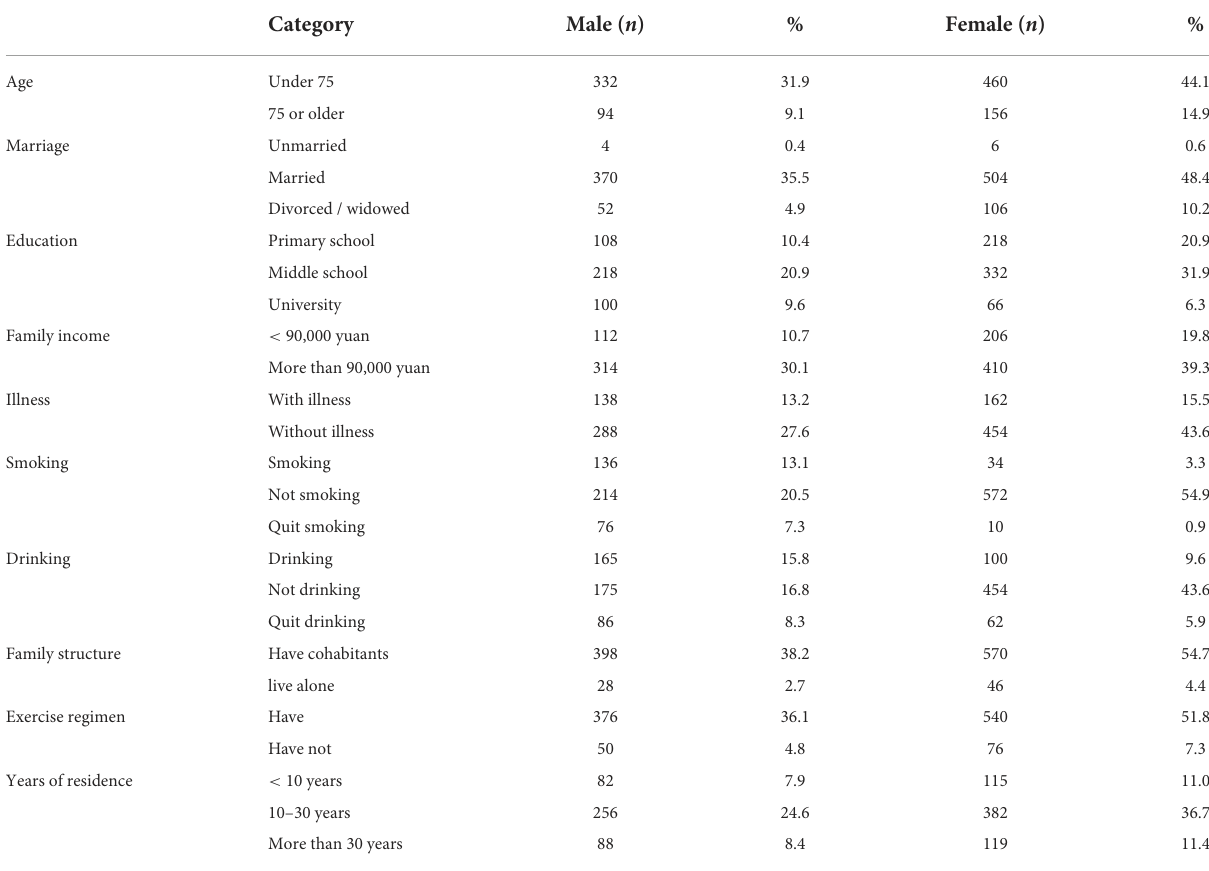
TABLE 1 Demographic characteristics of